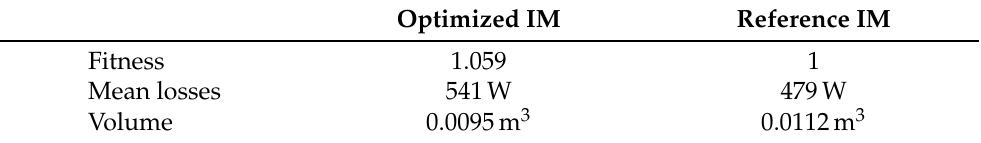
Figure 7. Loss operating maps of the reference ( a ) and optimized machine ( b ). Table 6. Fitness values and decision parameters resulting from the